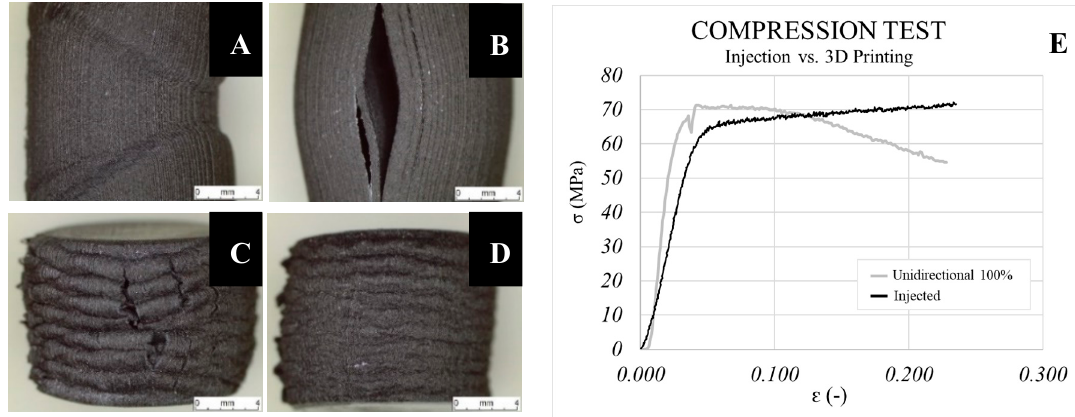
Figure 10. Fracture images of samples under compressive stress. ( A ) Unidirectional 100%, ( B ) unidirectional 60%, ( C ) triangles 60% and ( D ) linear ± 45. ( E ) Comparison between the injected and printed samples in the compression test.